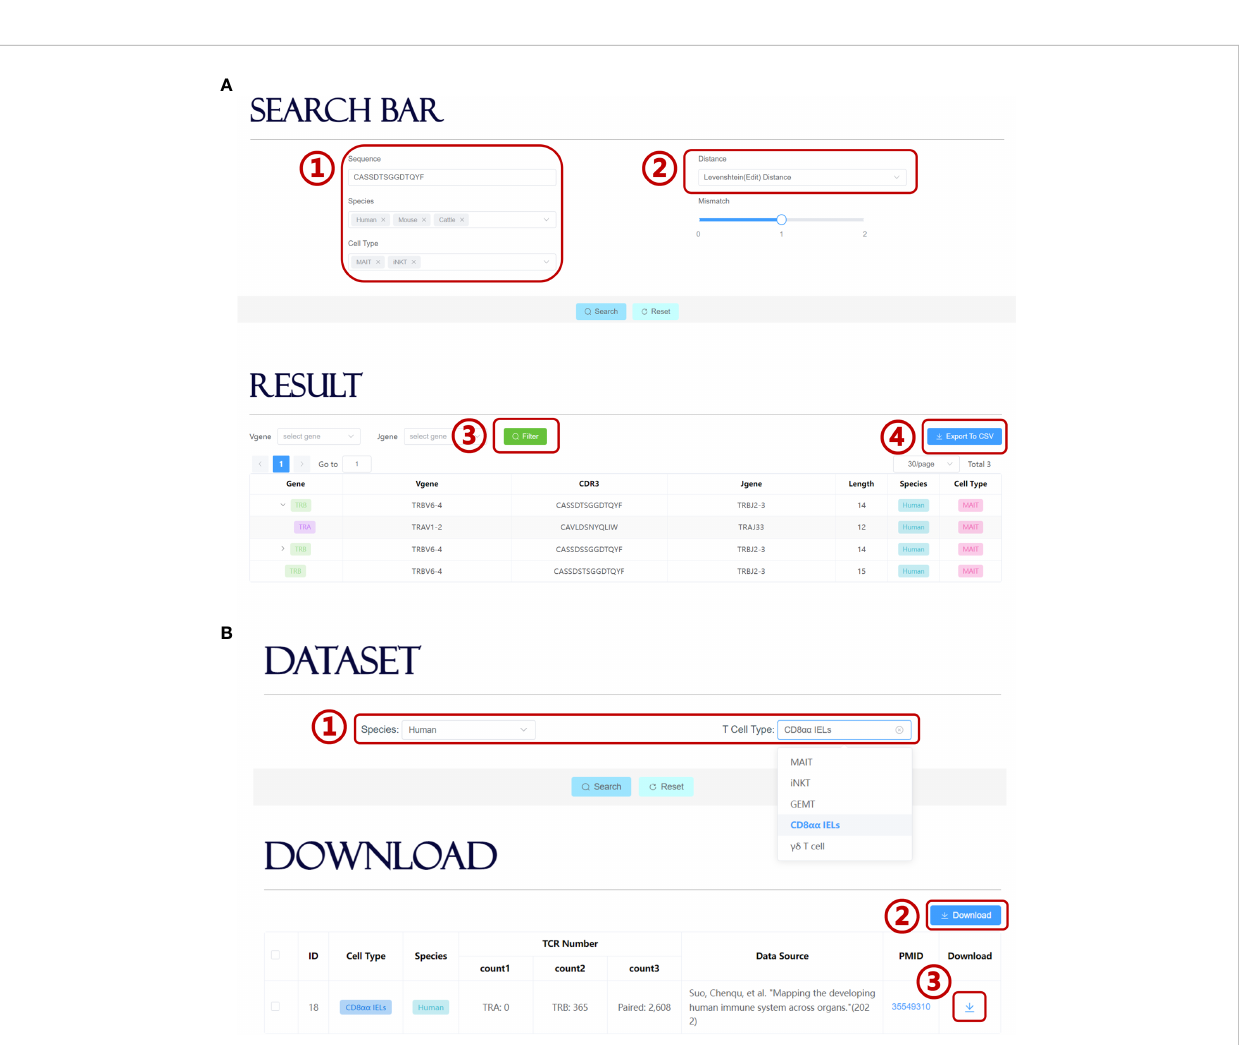
FIGURE 4 Search module and download module in UcTCRdb. (A) Screenshot of the search module page (1). Input the query sequence and set species and cell type conditions (2). Select a preset distance calculation method for fuzzy search (3). UcTCRdb allows a secondary fi lter performed to the result with a speci fi c V or J gene usage by clicking on the fi lter button (4). The search results can be downloaded by clicking on the ‘ Export To CSV ’ button. (B) Screenshot of the download module page (1). Select unconventional TCR datasets in different species and cell subpopulations (2). Users can download all the selected datasets by directly clicking the download button or down individual datasets one by one